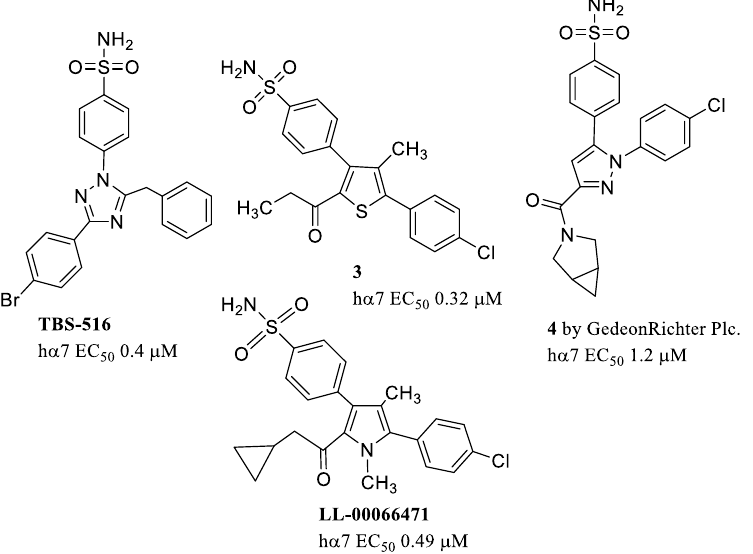
Figure 11. Arylsulfonamide allosteric modulators.